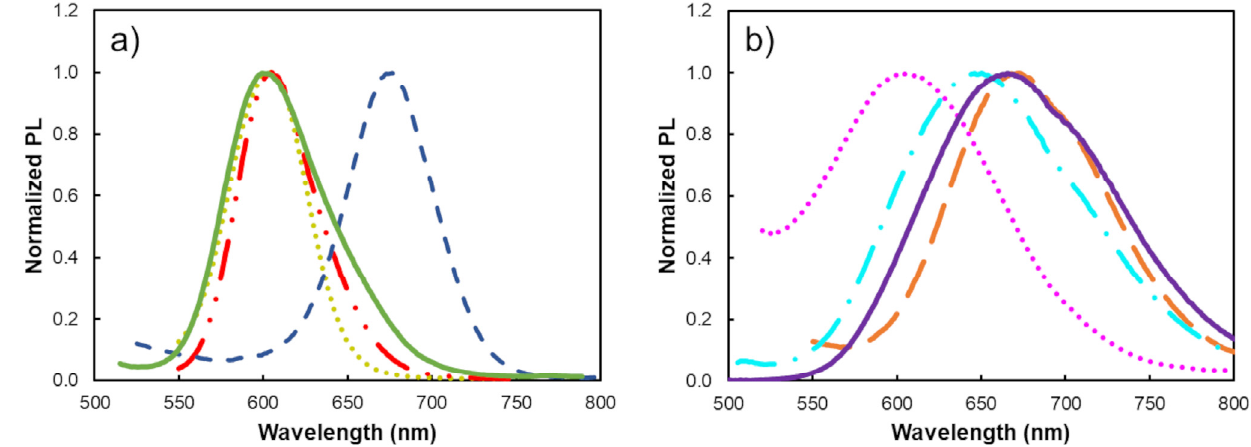
Figure 1. Normalized photoluminescence (PL) spectra of the ( a ) binary CdTe capped with thiomalic acid (TMA) ( ), glutathione (GSH) ( ), 3-mercaptopropionic acid (MPA) ( ) and 2-mercaptoethanesulfonate MES ( ). Table 1. PL lifetime values of each synthesized binary CdTe quantum dots.